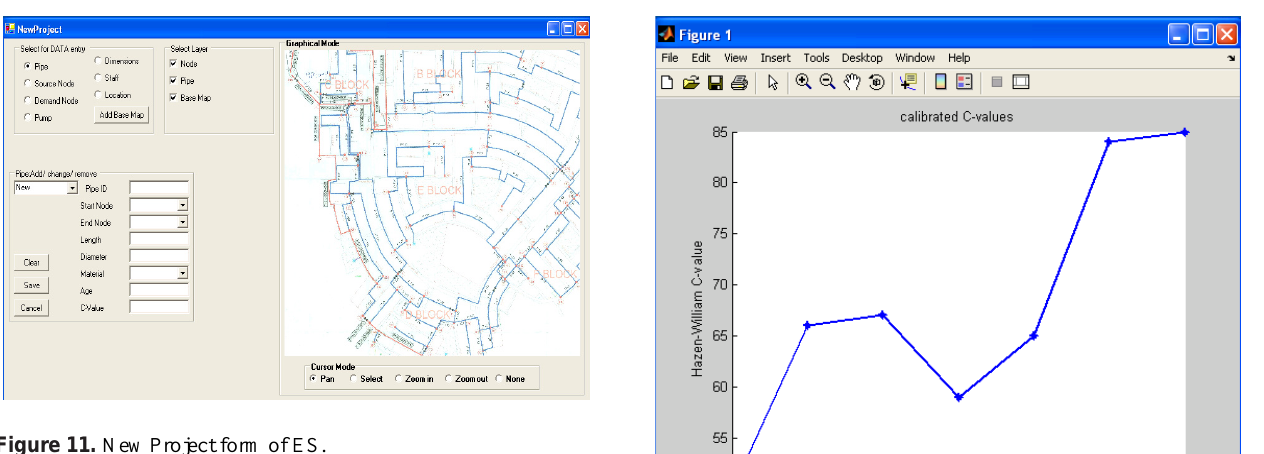
Figure 11. New Project form of ES. 10 Fig. 9. Screen shot of Daily Run Module of DSS showing sub- Fig. 11. New Project form of ES